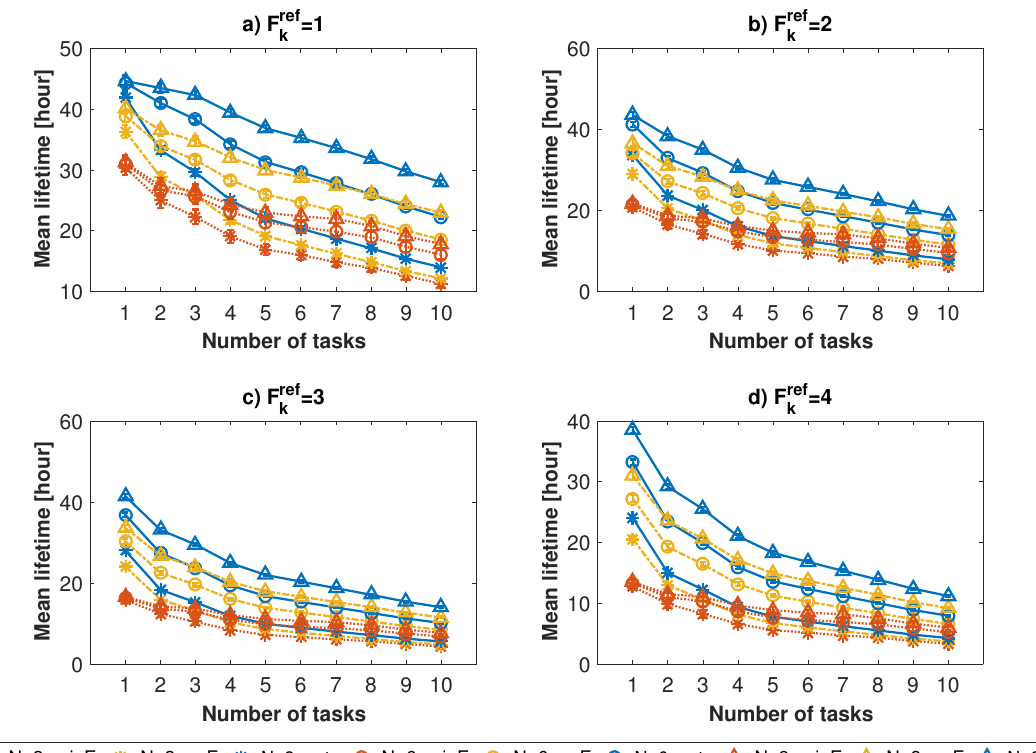
Figure 7. Average values of network lifetimes when the number of tasks increases, for a number of available nodes equal to 3 (star marker), 6 (circle marker) and 9 (triangle marker). Results are shown for reference frequency values equal to 1 ( a ); 2 ( b ); 3 ( c ) and 4 ( d